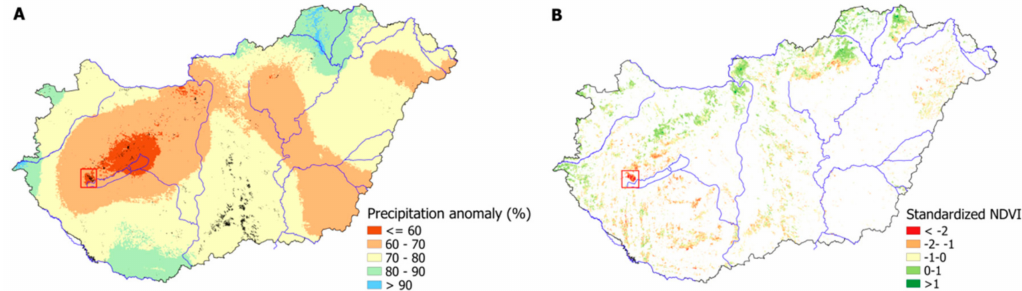
Figure 3. ( A ) Precipitation anomaly (%) of 2011–2012 relative to the long-term mean (1951–2000) and the ( B ) standardized mean normalized difference vegetation index (NDVI) of the months Aug–Sep in 2012 (red rectangle denotes the study area, grey dots the Black pine